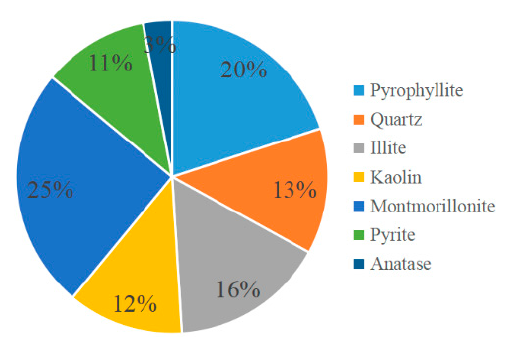
Figure 1. The mineral analysis of coal bed methane (CBM) reservoir sample.